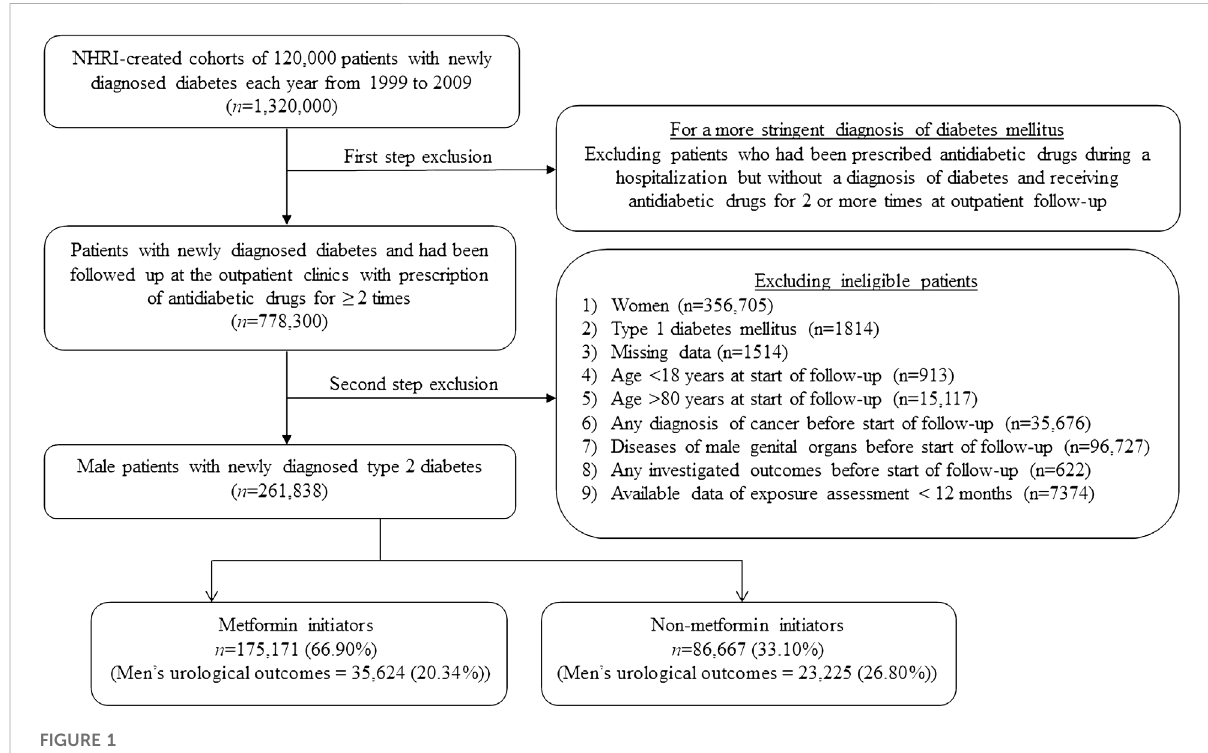
FIGURE 1 Flowchartshowingtheproceduresusedinthecreationofacohortofmetformininitiatorsandnon-metformininitiatorsfromTaiwan ’